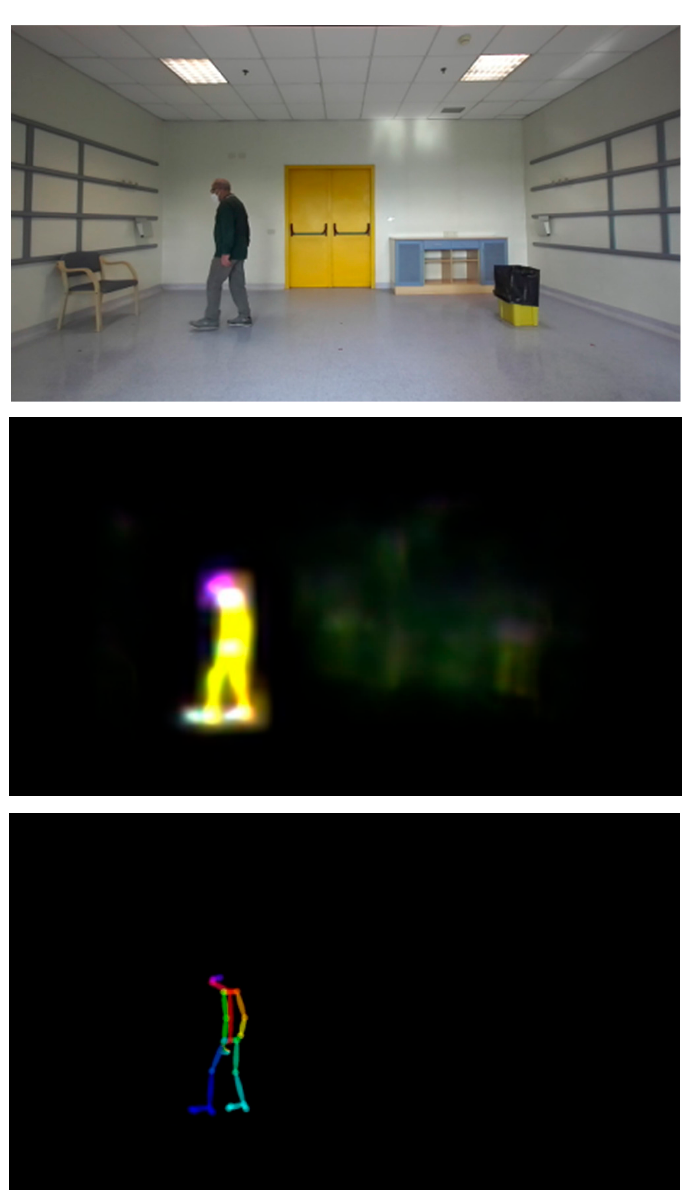
Figure 4. Top: Input image; middle: computed PAFs; bottom: subject’s KeyPoints and Parts. Figure 4. ( top ) Input image; ( middle ) computed PAFs; ( bottom ) subject’s KeyPoints and